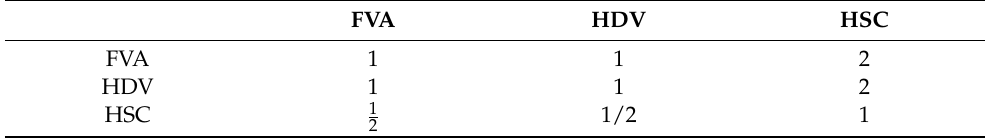
Table 2. The pairwise comparison matrix of the land use factors.